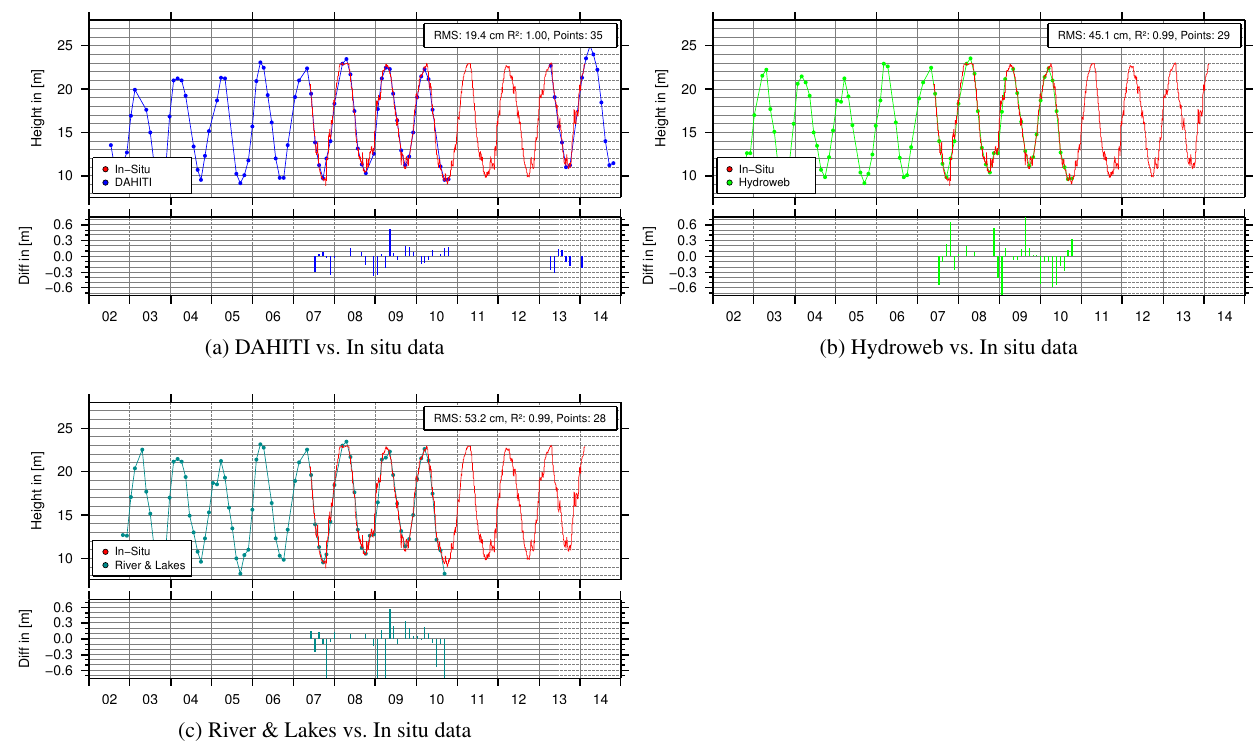
Figure 8. Water level time series of the Madeira River from DAHITI (2002–2014), Hydroweb (2002–2010), and River & Lake (2002–2010) compared with in situ data (Humaitá, 2007–2014) and shifted to the water level height of the in situ data. Additionally, differences between heights from altimetry and in situ data are plotted for periods in which both data sets are available.